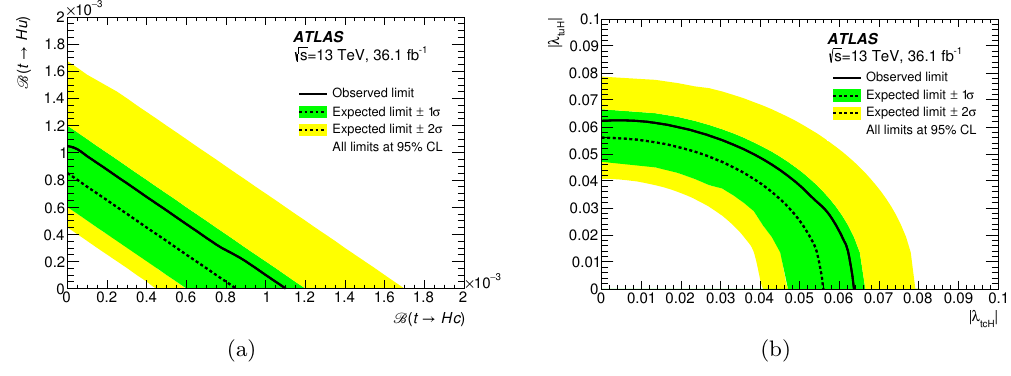
Figure 15 . 95% CL upper limits (a) on the plane of B ( t ! Hu ) versus B ( t ! Hc ) and (b) on the plane of j (cid:21) tuH j versus j (cid:21) tcH j for the combination of the searches. The observed limits (solid lines) are compared with the expected (median) limits under the background-only hypothesis (dotted lines). The surrounding shaded bands correspond to the 68% and 95% CL intervals around the expected limits, denoted by (cid:6) 1 (cid:27) and (cid:6) 2 (cid:27) ,